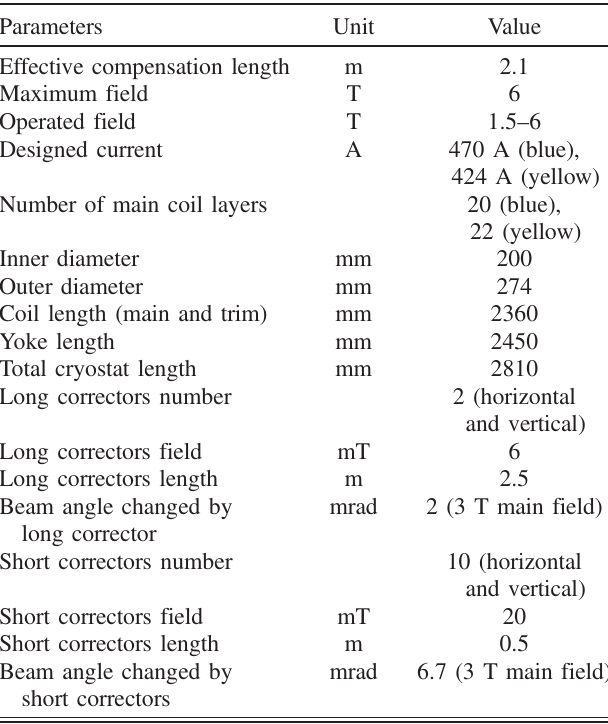
TABLE II. Parameters for the RHIC electron lens supercon- ducting solenoid.